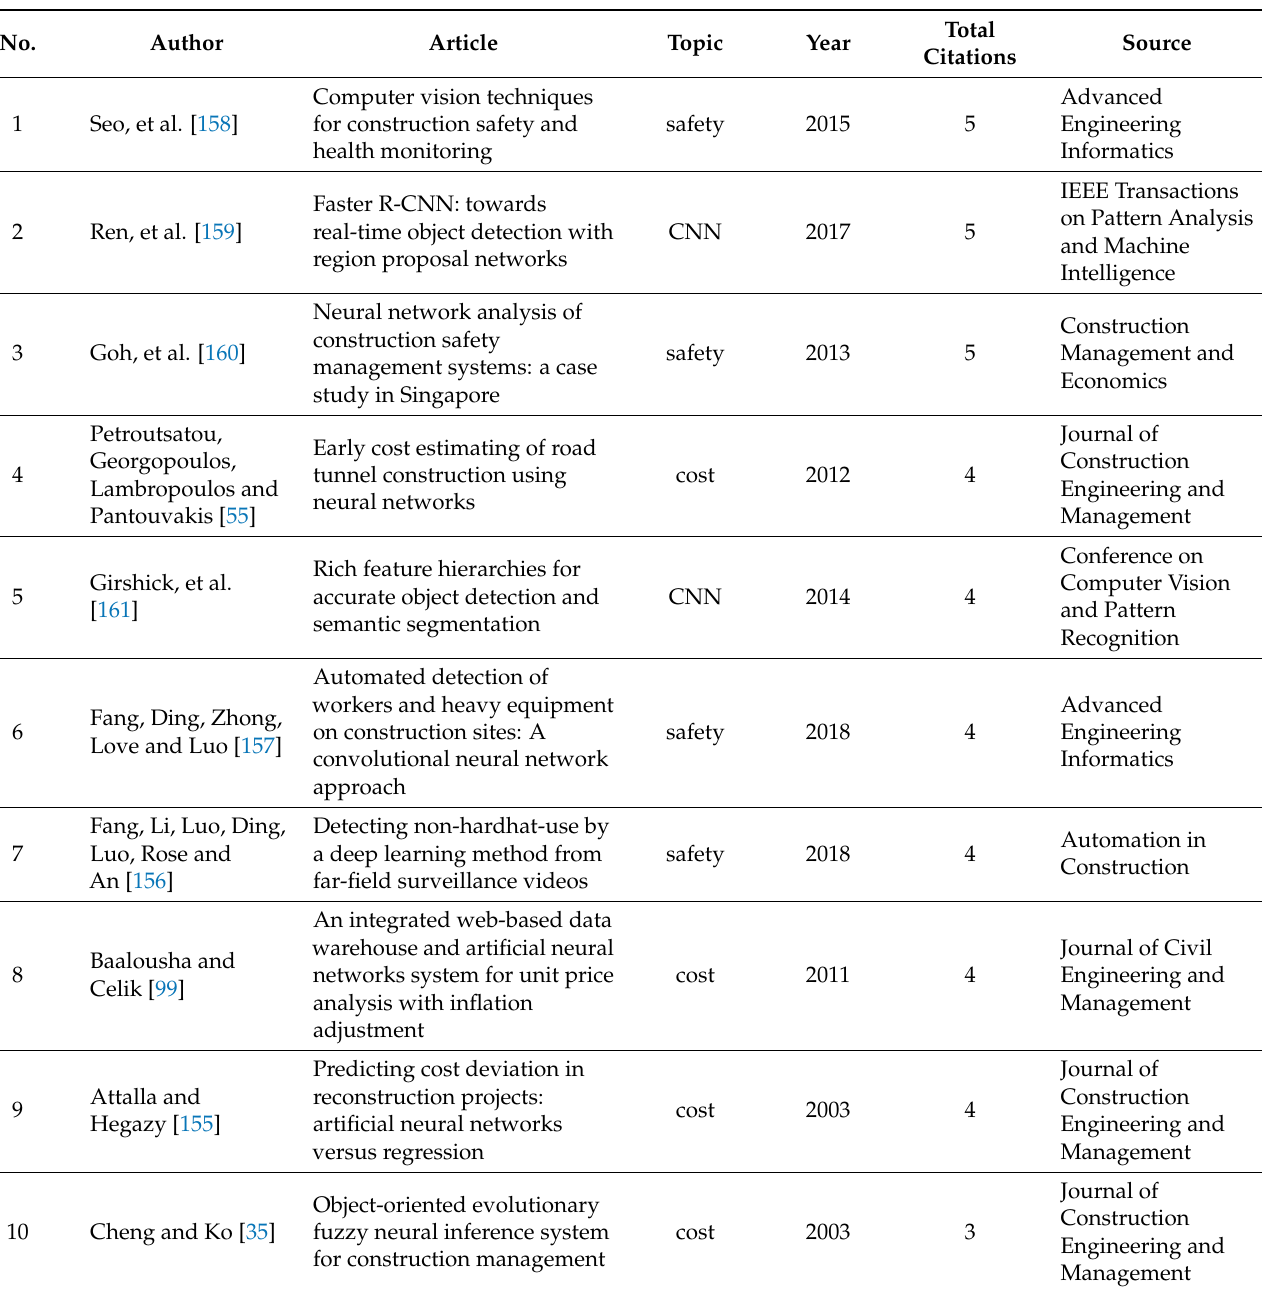
Table 3. Top 10 highly co-cited